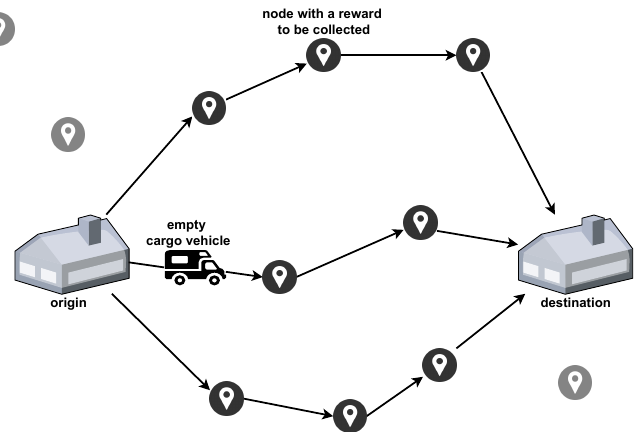
Figure 2. Network topology of a basic